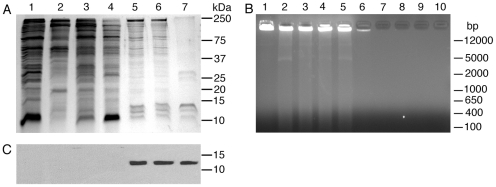
The analysis of the parasite nuclear material and extracts of nuclear material.
Panel A: The parasite nuclear material, polynucleosomes and buffer/salt extracts of nuclear material were analyzed for proteins by SDS-PAGE (in each lane 15 µg of protein content/well). Lane 1, the supernatant of parasite lysate (see Figure 1 for materials in lanes 1–6); lane 2, 0.3 M KCl extract of the nuclear material; lane 3, 0.6 M KCl extract of the chromatin material; lane 4, 0.4 M NaCl extract of the chromatin material; lane 5, chromatin material after extraction of proteins with buffer A containing various salts; lane 6, polynucleosomes; lane 7, the mixture of standard recombinant histones, H1, H2A, H2B, H3 and H4. The mobility of molecular weight marker proteins is indicated to the right. Panel B: The parasite nuclear material and buffer/salt extracts of nuclear material were electrophoresed on 0.8% agarose gels and the DNA bands were visualized under UV light after ethidium bromide staining. Lane 1, parasite nuclear material before extraction of proteins that loosely bound to chromatin (see Figure 1 for materials in lanes 1–10); lane 2, chromatin material pellet after extraction with buffer/0.3 M KCl; lane 3, chromatin material after extraction with buffer/0.6 M KCl; lane 4, chromatin material after extraction with buffer/0.4 M NaCl; lane 5, soluble polynucleosomes; lane 6, insoluble fibrous material after obtaining polynucleosomes; lane 7, parasite cytoplasmic material plus membrane fragments; lane 8, 0.3 M KCl extract of nuclear material; lane 9, 0.6 M KCl extract; lane 10, 0.4 M NaCl extract. Lanes 1–5, materials having 0.5 µg DNA were analyzed. Lane 6, about 60-fold more material as compared to those in lanes 1–5 based on the total parasite amount used for fractionation. Lanes 7–10, materials equivalent to that in lanes 1–5 based on the total amount of parasite used for fractionation was loaded. The sizes of standard DNA makers are indicated to the right. Panel C: Western blotting of parasite components as shown in panel A was done using anti-H3 histone polyclonal antibodies. Lane descriptions are as outlined in panel A.